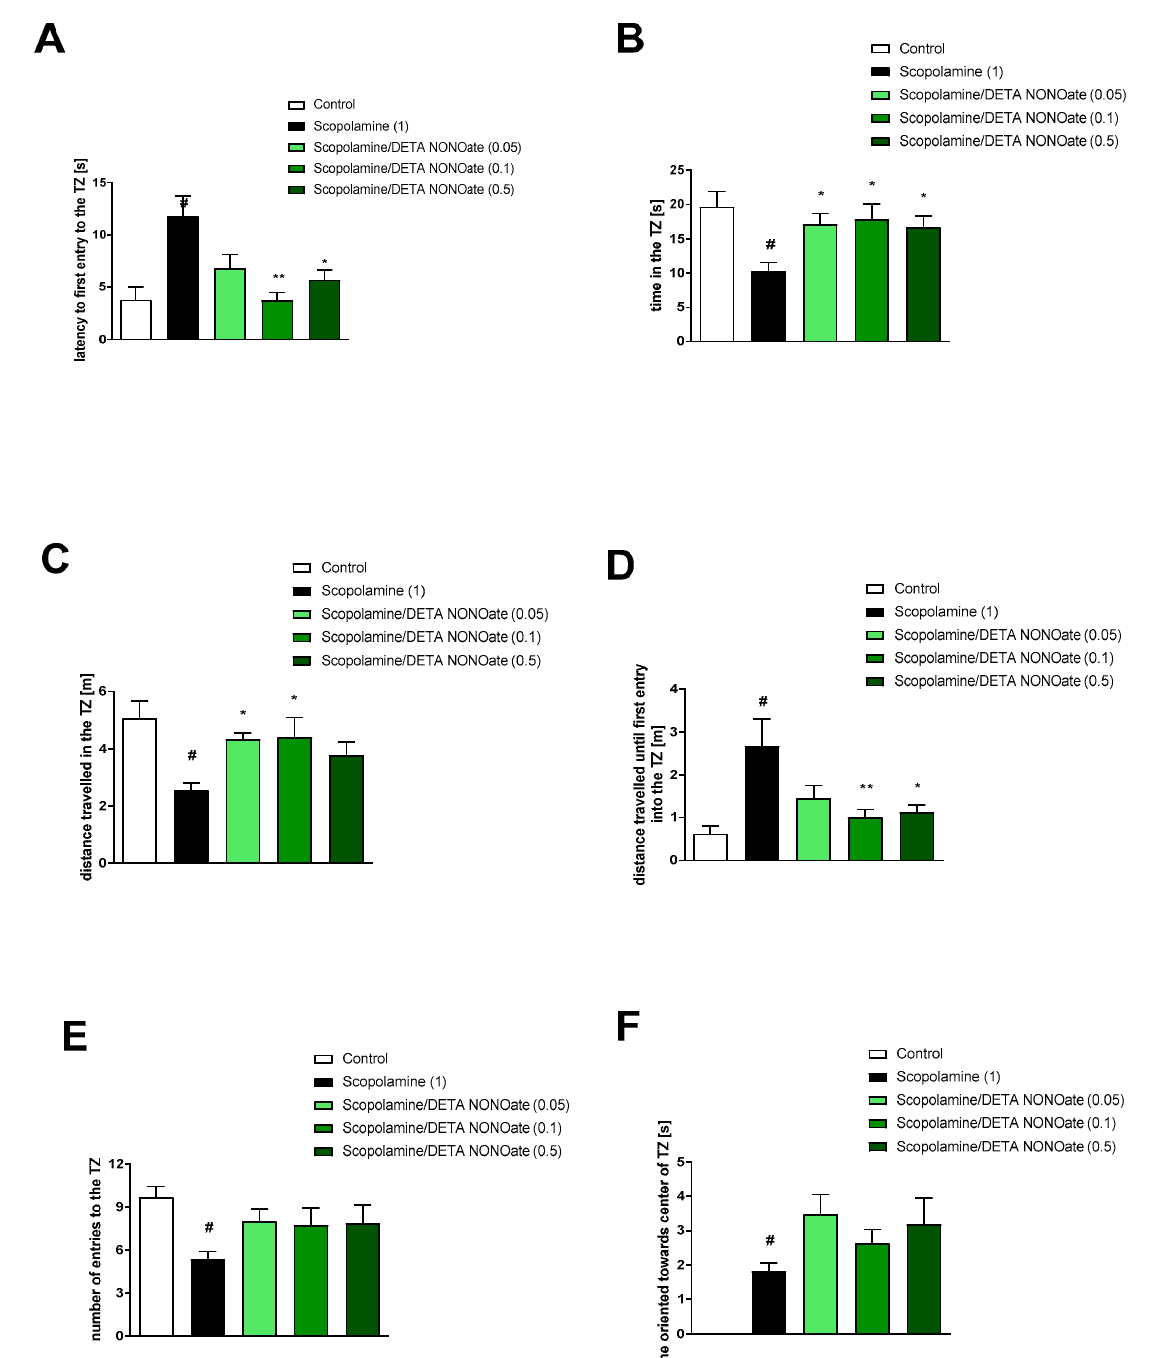
Figure 6. The effects of DETA NONOate on scopolamine-induced deficits in the retention of spatial memory in the MWM of CD1 mice. TZ-related parameters. ( A ) latency to the first entry into the TZ, ( B ) time in the TZ, ( C ) the distance travelled in the TZ, ( D ) the distance travelled until the first entry into the TZ, ( E ) the number of entries into the TZ, and ( F ) the time oriented towards the centre of the TZ when inside the zone. The values are expressed as means ± SEM. # p < 0.001 vs. control group and * p < 0.05; ** p < 0.005 vs. scopolamine-treated animals (N =